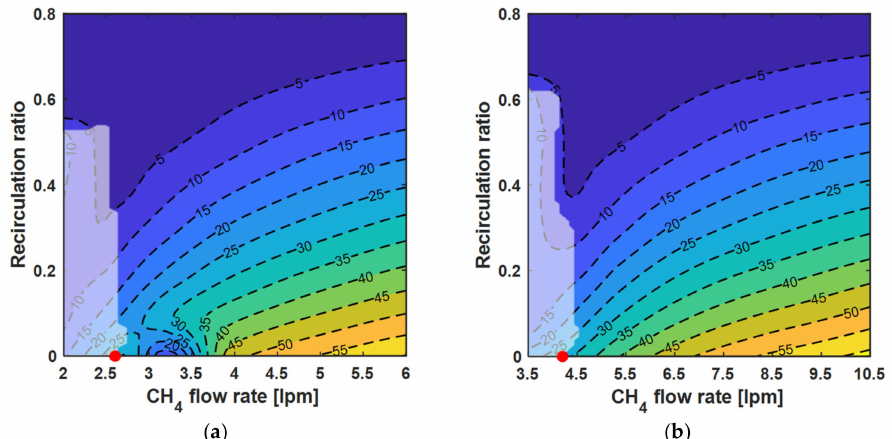
Figure 7. Change in thermal efficiency with various fuel flow rates and recirculation ratios at operating current densities of ( a ) 0.3 A/cm 2 and ( b ) 0.5 A/cm 2